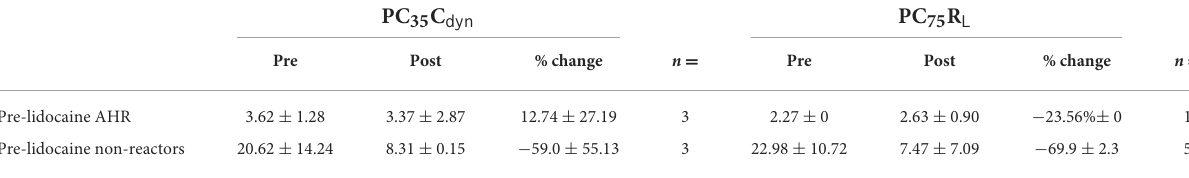
TABLE 6 PC 35 C dyn and PC 75 R L before and after nebulized lidocaine administration in 6 healthy horses with and without baseline airway hyperresponsiveness